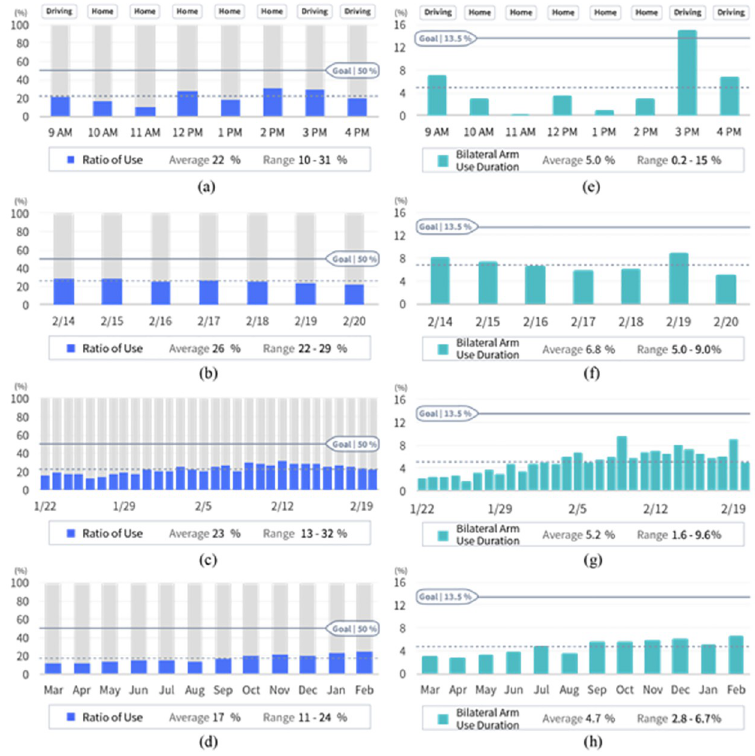
Fig 3. Example bar charts that we presented to OTs: Ratio of Use (left) and Bilateral Arm Use Duration (right). The data shown in the charts for Affected Arm Use Duration are similar to those in the Bilateral Arm Use Duration charts and hence are omitted here due to space limitation. The day graphs, (a) and (e), presented the averaged value of the measures for each hour, which were obtained from one of the two days (i.e., the second day) data that we collected with James. We showed the average, minimum, and maximum values of the measure across the eight-hour period at the bottom of the graph. The average value was also presented on the bar graph using a dotted gray horizontal line. The solid line represented the goal that therapists could set for a particular patient to reach, although we arbitrarily set the goal (e.g., 50% for the Ratio of Use that represents balanced bilateral arm use) for the presentation purpose. The annotations shown above the bars (e.g., Driving and Home) were computed using the Google Maps Timeline data obtained from the smartphone that was given to James. The week, month, and year graphs similarly presented the three performance measures. Because we only collected data from James over two days, all data, except for the data pertaining to the last two days of the week graph (i.e., data on 2/19 and 2/20 in Figure(b) and (f)), were synthesized to represent some plausible trends of arm performance level (e.g., improvement or